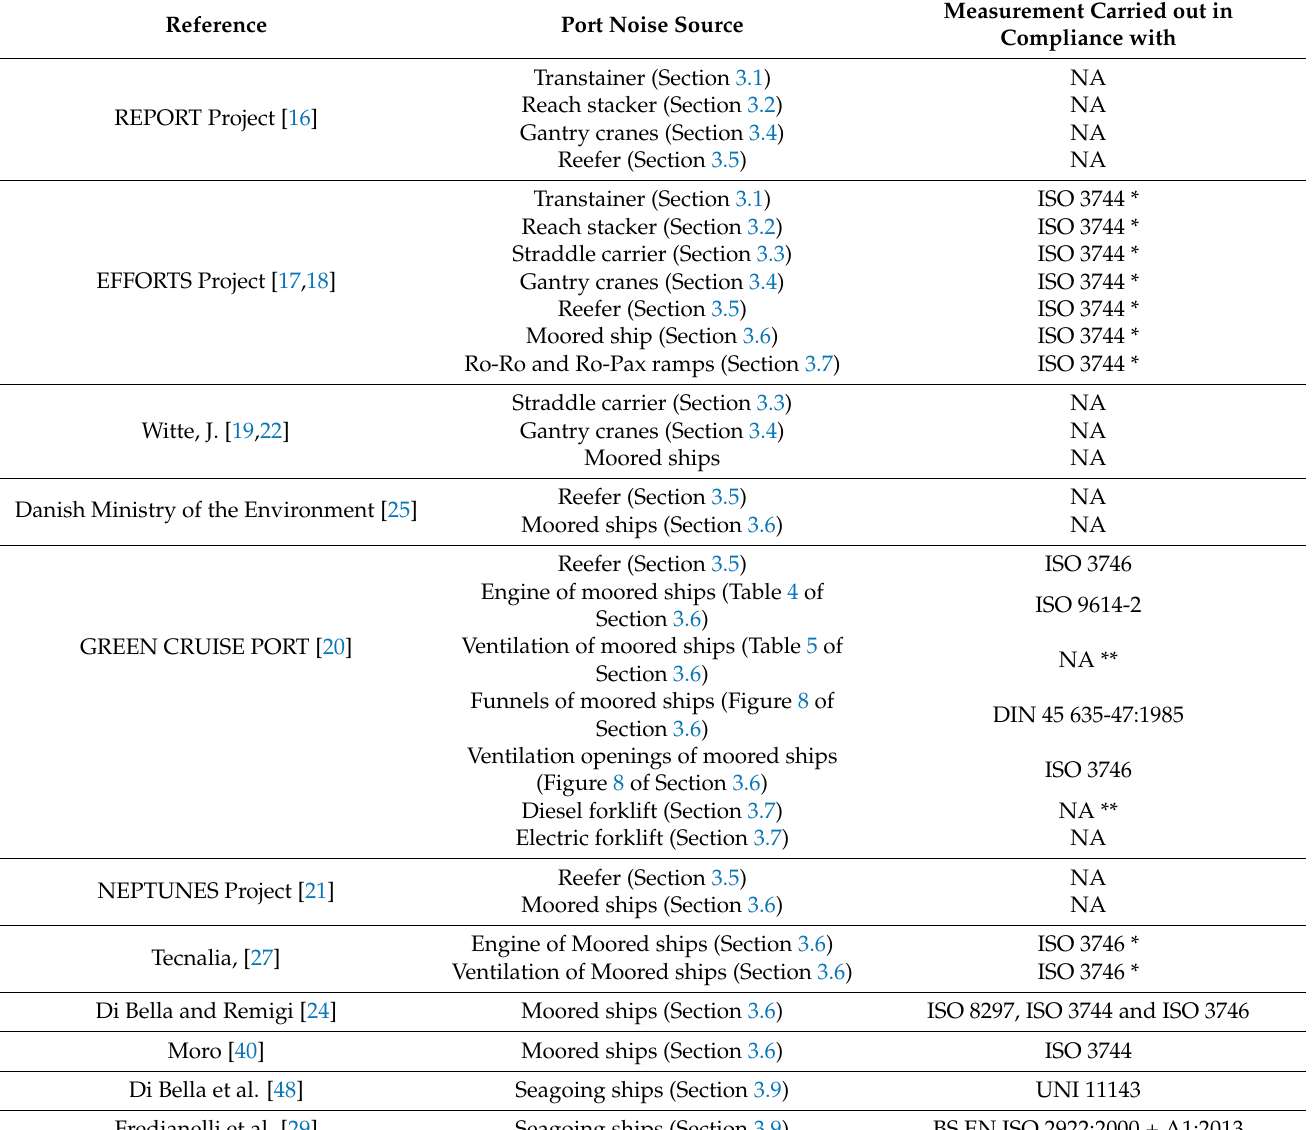
Table A1. Standards used in the acoustic measurements carried out to define the sound power level of port noise